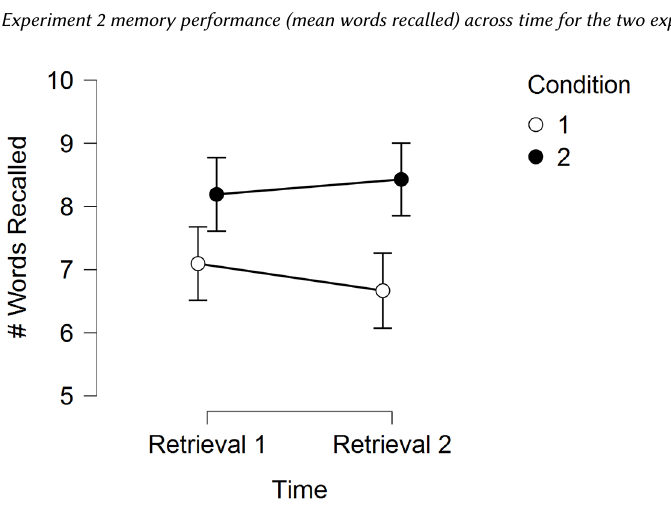
Note . Error bars are standard